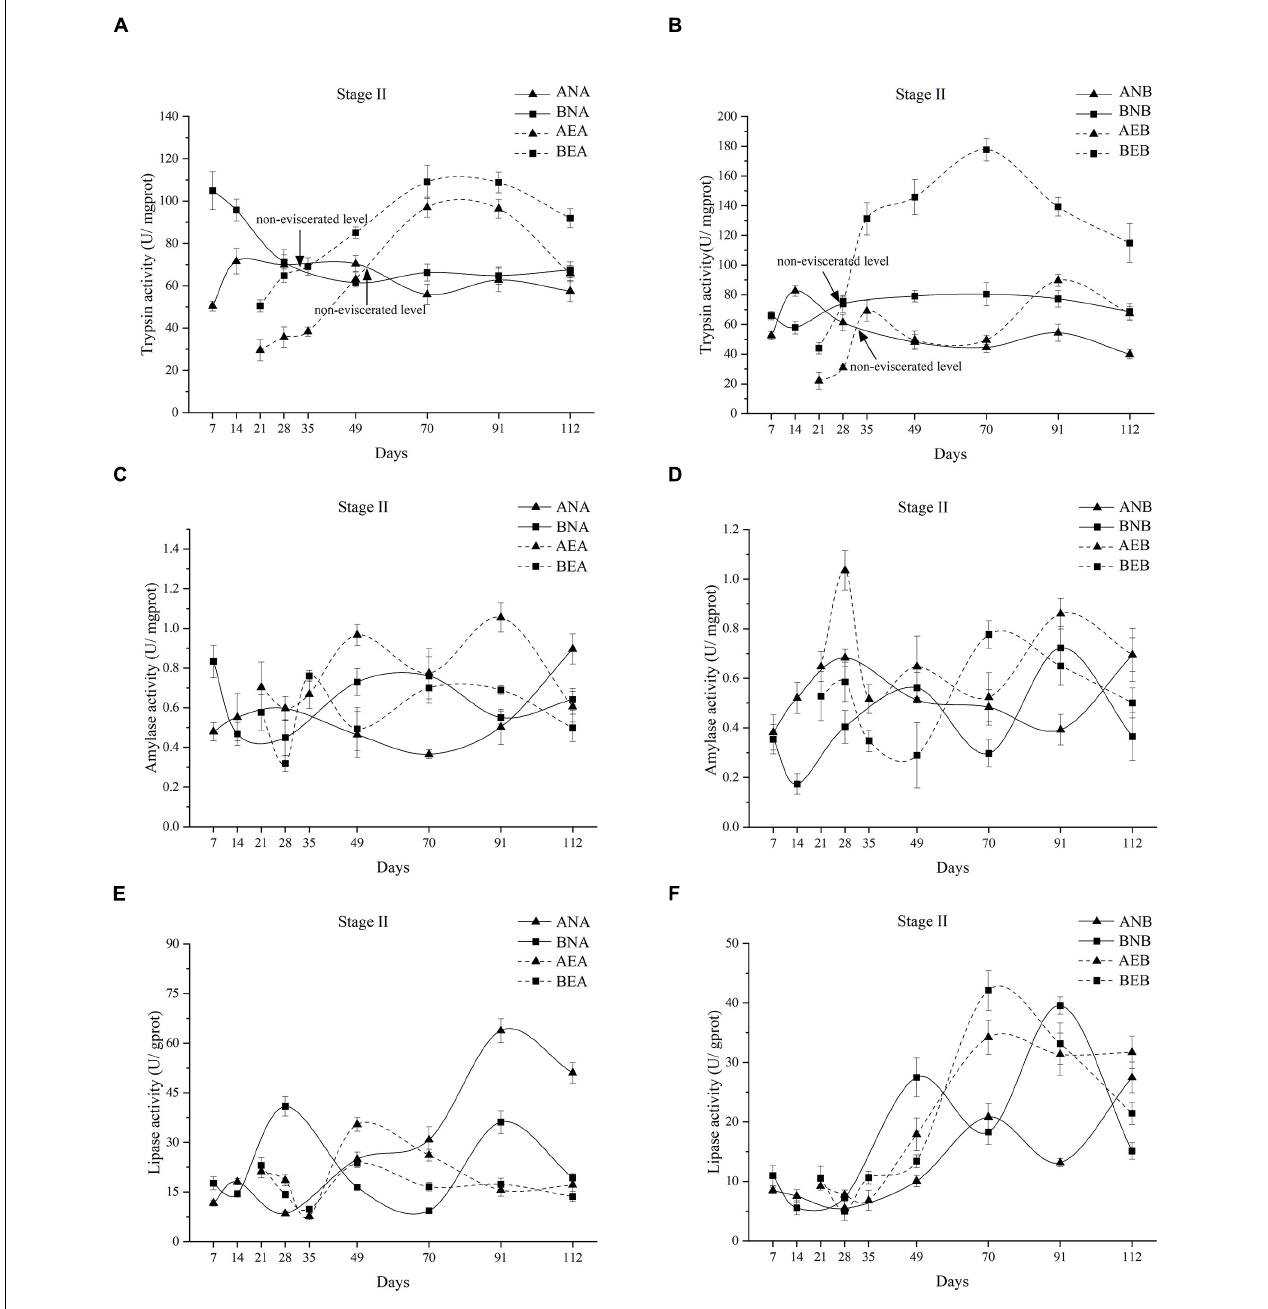
FIGURE 3 | Changes in trypsin activities of A. japonicus feeding different diets in stage II (A,B) . Non-eviscerated levels of trypsin activities indicate the intersection of the eviscerated group and its corresponding non-eviscerated group. Changes in amylase activities of A. japonicus feeding different diets in stage II (C,D) . Changes in lipase activities of A. japonicus feeding different diets in stage II (E,F) . Data are presented as mean ± SD ( n =